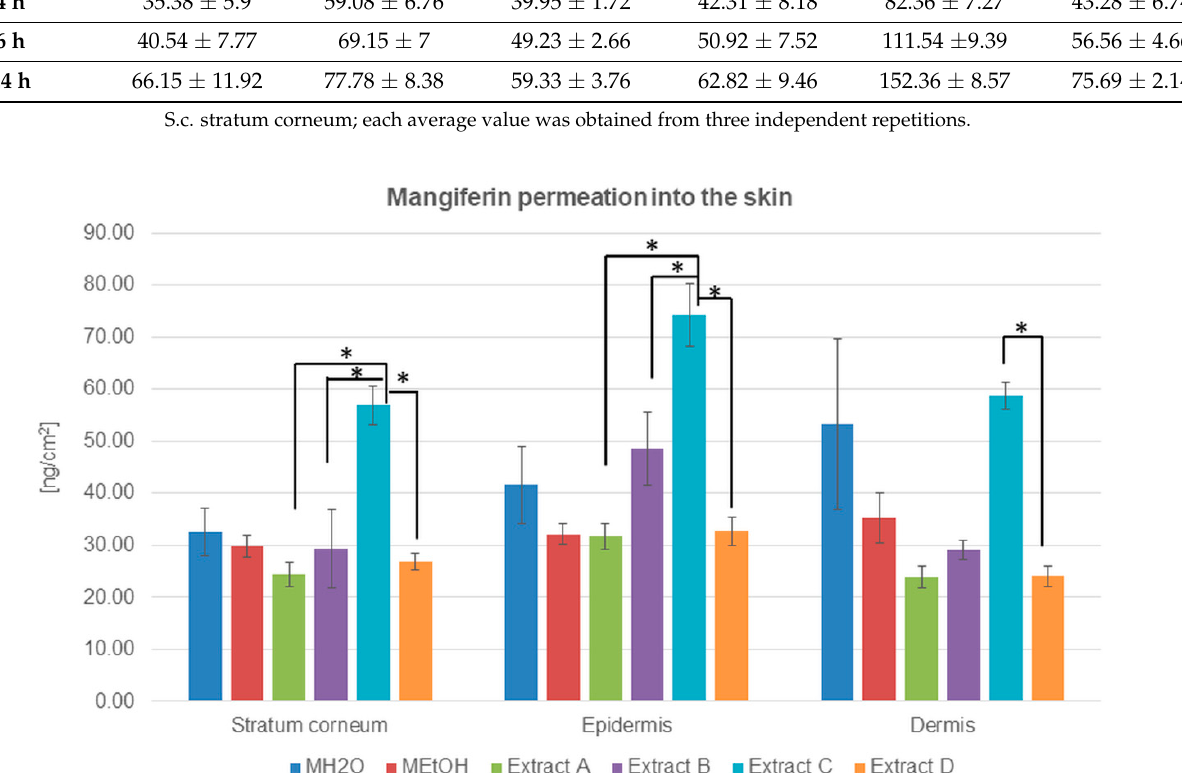
Figure 4. Mangiferin distribution among skin layers: stratum corneum, epidermis, and dermis (ng/cm 2 ) after application and 24 h of incubation of mangiferin solutions: water (MH 2 O, 25 μ g/mL), ethanol (25 μ g/mL, MEtOH, 50% ( v/v )), or honeybush extracts: A, B, C, D. Each average value was obtained from three independent repetitions. Error bars represent standard deviations. Significant differences among samples are marked with an asterisk ( p < 0.05).